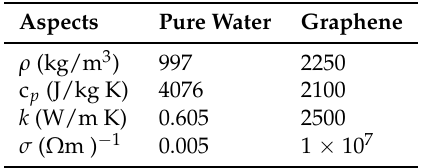
Table 1. Different aspects of H 2 O and tiny